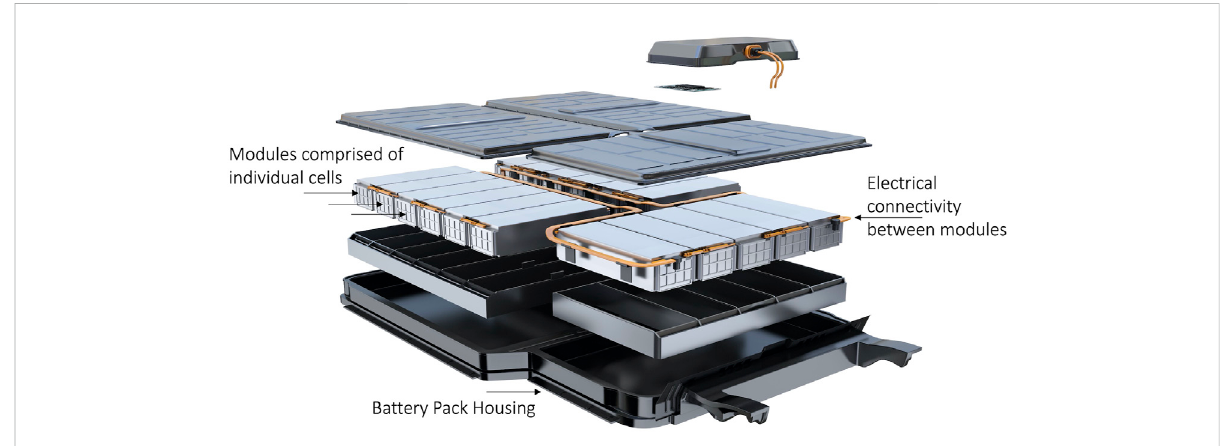
FIGURE 4 Diagram of a battery pack showing the pack and module components in a battery pack. Electronic connectivity between modules is shown in orange wires.